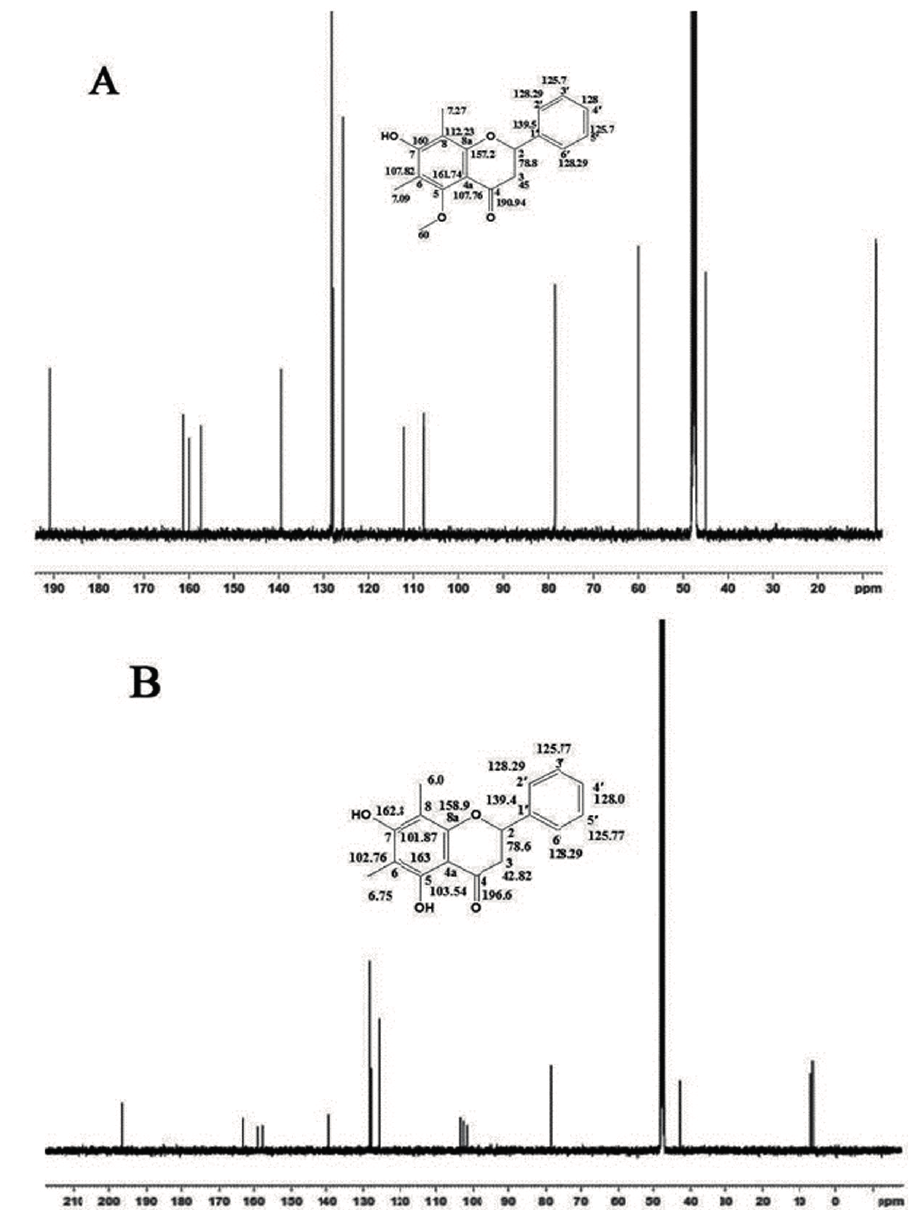
Figure 5. 13 C-NMR-spectra of compounds: (2 S )-7-Hydroxy-5-methoxy-6,8-dimethyl flavanone ( A ) and ( S )-5,7-dihydroxy-6,8-dimethyl flavanone ( B ). 13 C-NMR spectrum: 13 C-NMR spectrum of compound ( 2 ) showed signals at δ : C-2 (78.6), C-3 (42.82), C-4 (196.6), C-4a (103.54), C-5 (163.0), C-6 (102.76), C-7 (162.8), C-8 (101.87), C-8a